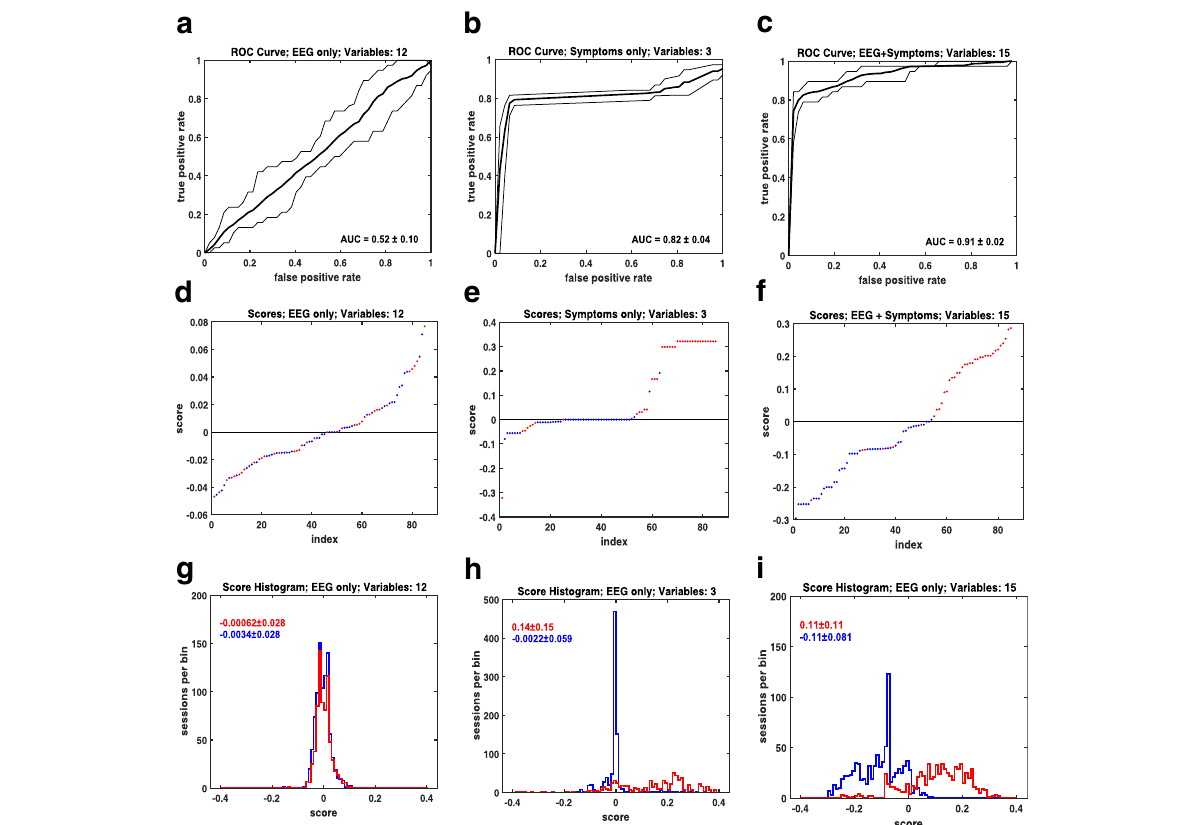
Fig. 2 ROC analysis results for the TotalBoost classification algorithm applied to the set of 85 subjects made of injured and control classes. Three cases are shown: EEG-only ( a , d , g ), symptoms-only ( b , e , h ), and EEG plus symptoms ( c , d , i ). The first row plots the ROC curves, the second row plots the ordered scores, and the third row shows the score distribution for the three cases. The AUC average and maximum/minimum variation are given in the ROC plots (top). The distribution means and standard deviations are shown in the distribution plots